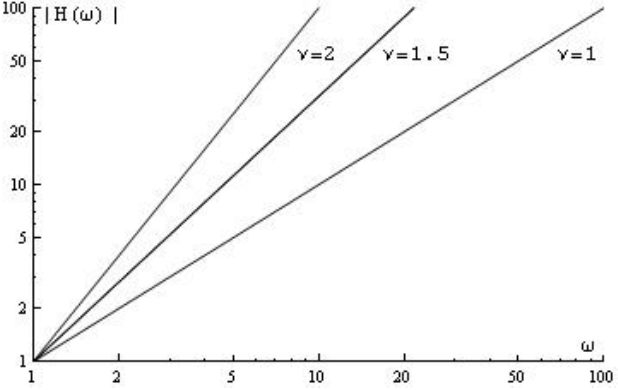
Figure 3. Moduli of the frequency responses of a fractional derivative with ν = 1 , ν = 1 . 5 and ν = 2